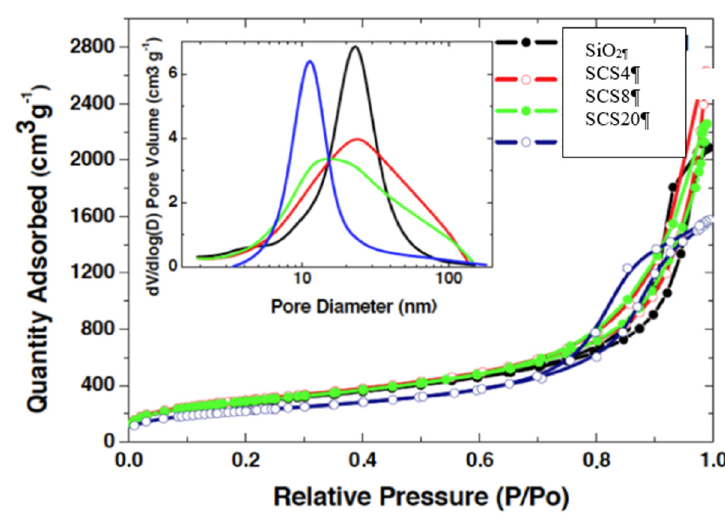
Figure 2. N 2 physisorption isotherms of the outlined aerogels. Inset, pore size distribution (PSD) from the BJH as pore size distribution model [10].